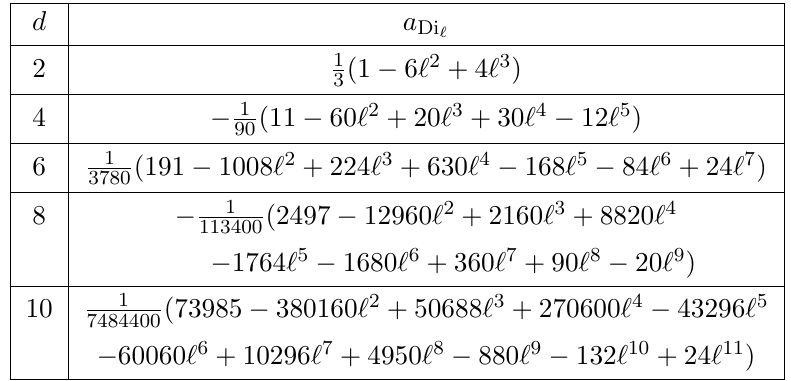
Table 2 . Summary of a -anomaly coefficients for the order- ℓ Dirac spinor in low